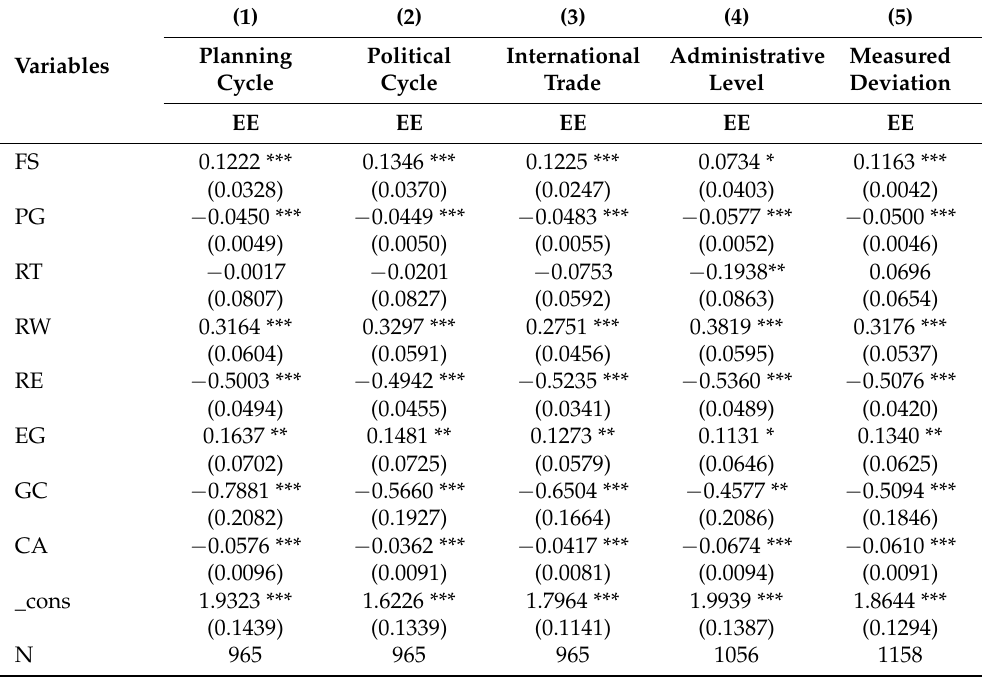
Table 5. The empirical results on robustness tests for